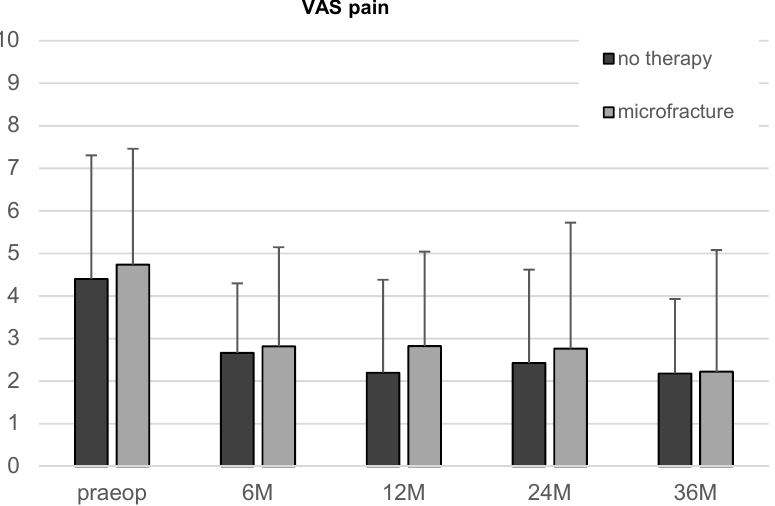
Figure 4. Results of the VAS for pain in patients undergoing microfracture or no therapy of their hip cartilage defects during arthroscopy from baseline to 36-month follow-up. Whiskers represent standard deviations.